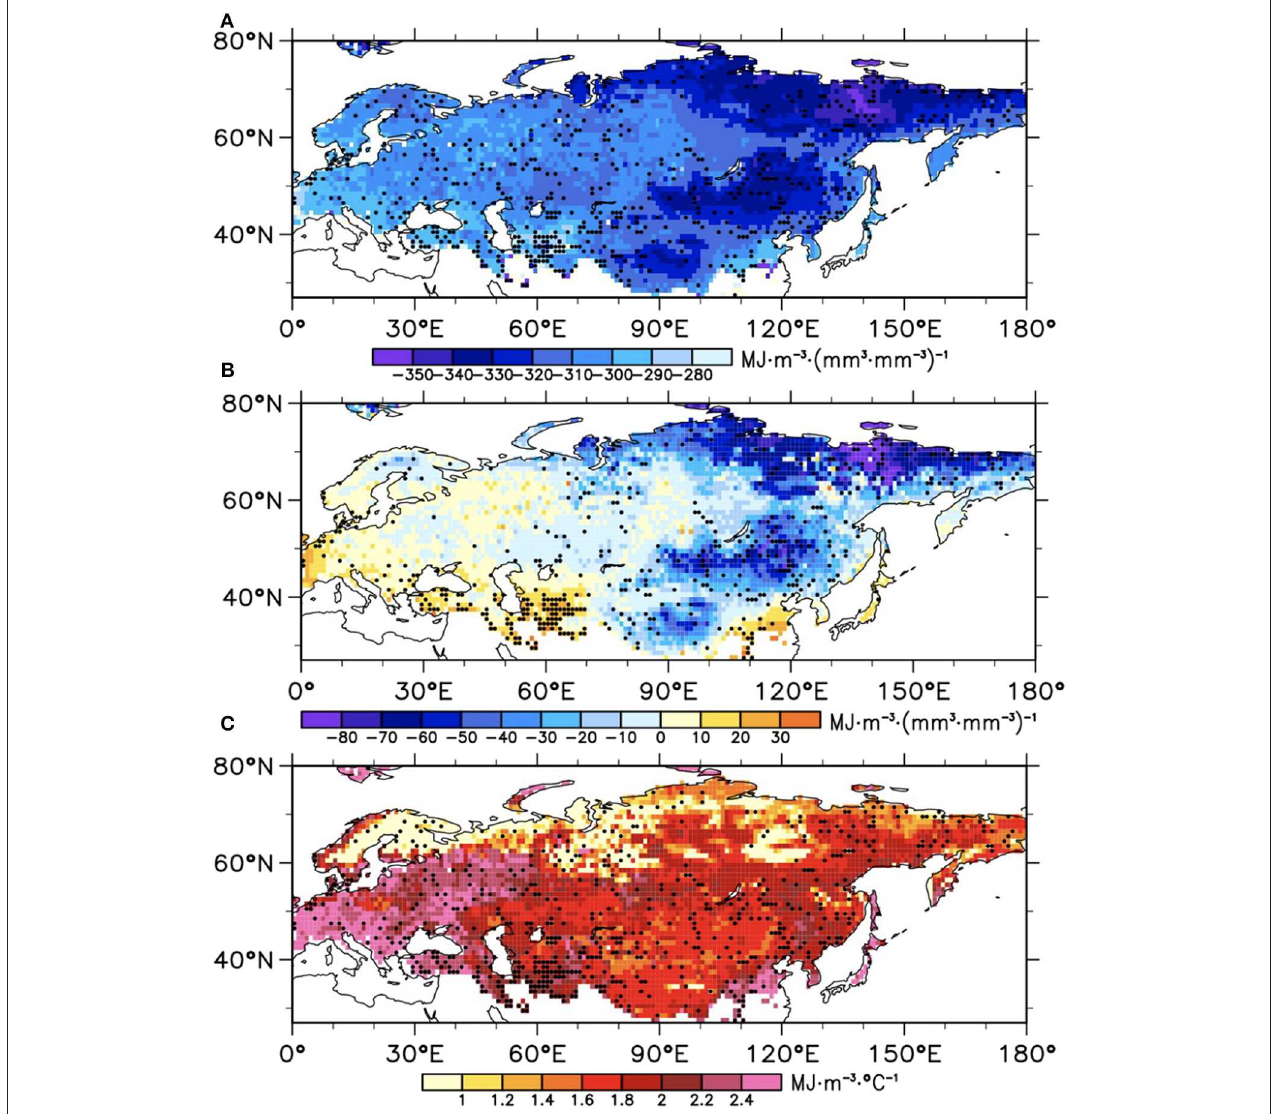
FIGURE 6 | The MLR coefficients of soil enthalpy on (A) soil ice ( a i ), (B) soil liquid water ( a l ), and (C) soil temperature ( b ) at mid-high latitudes. The regions with solid black dots represented the coefficients were statistically significant ( p < 0.05) after